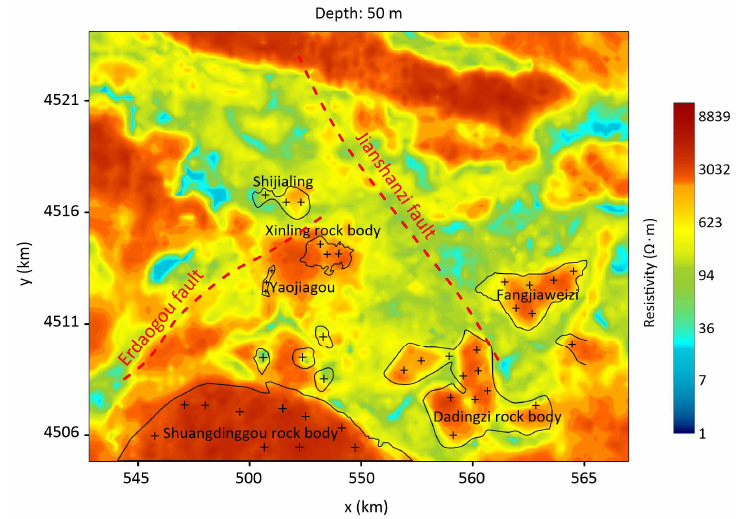
Figure 7. Comparison between the 50-m depth slice of the resistivity model and the geological data in Figure 2 (the missing data of the inversion result are obtained by interpolation, which is also applied in the following figures).